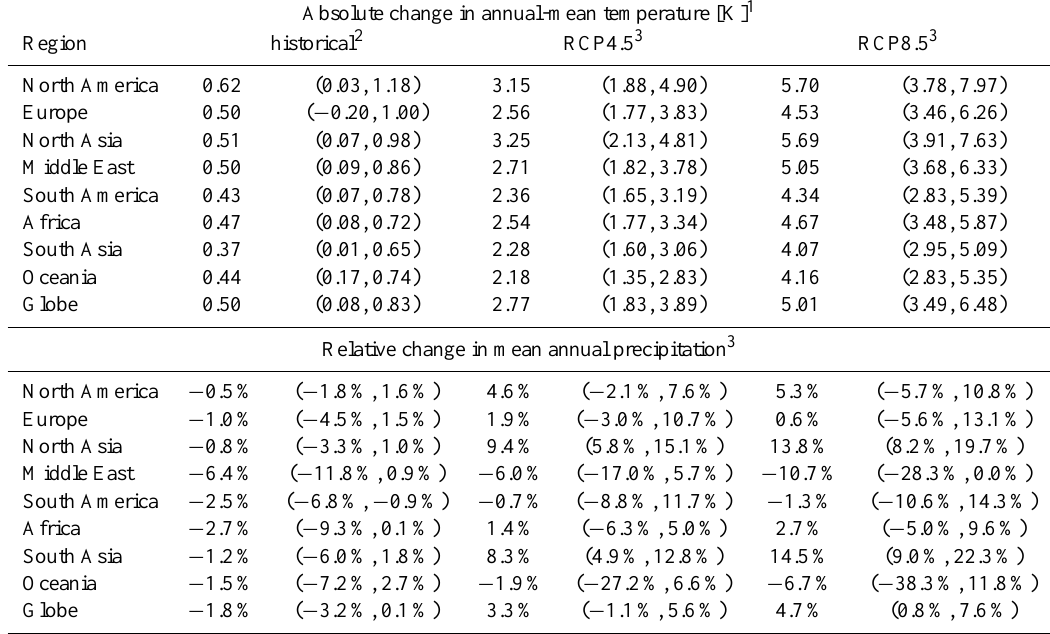
Table 1. Simulated changes in climate by